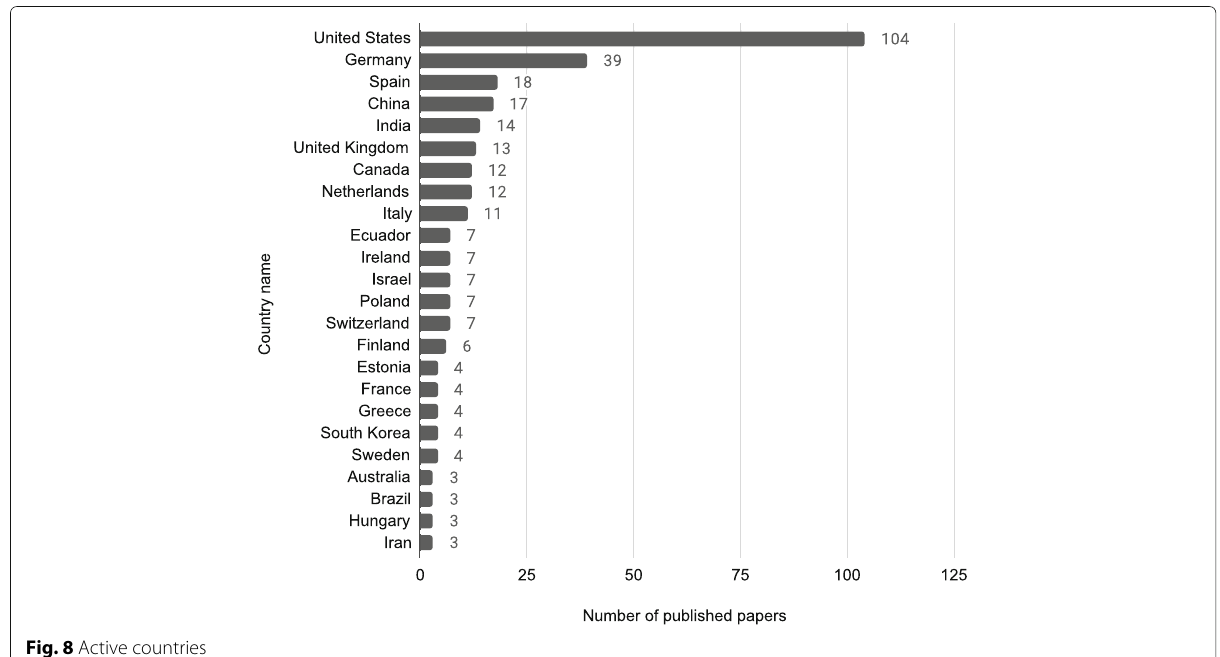
Fig. 8 Active countries